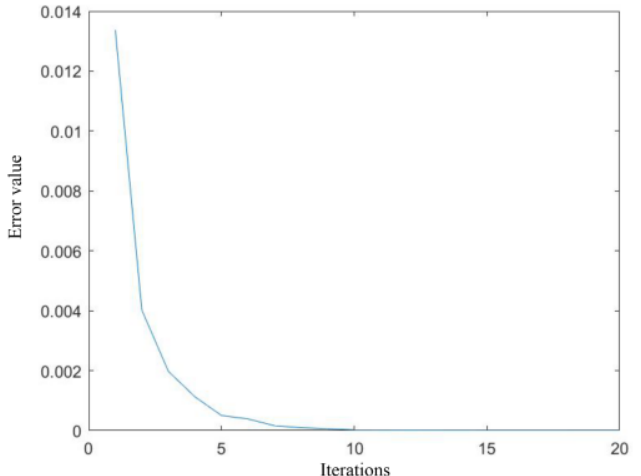
Figure 5. Iterative error curve of inversion.